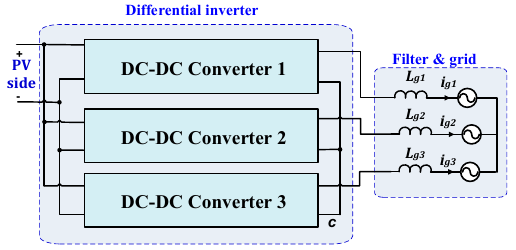
Figure 7. Di ff erential mode three-phase microinverter. Figure 7. Differential mode three-phase microinverter. Figure 7. Differential mode three-phase microinverter.